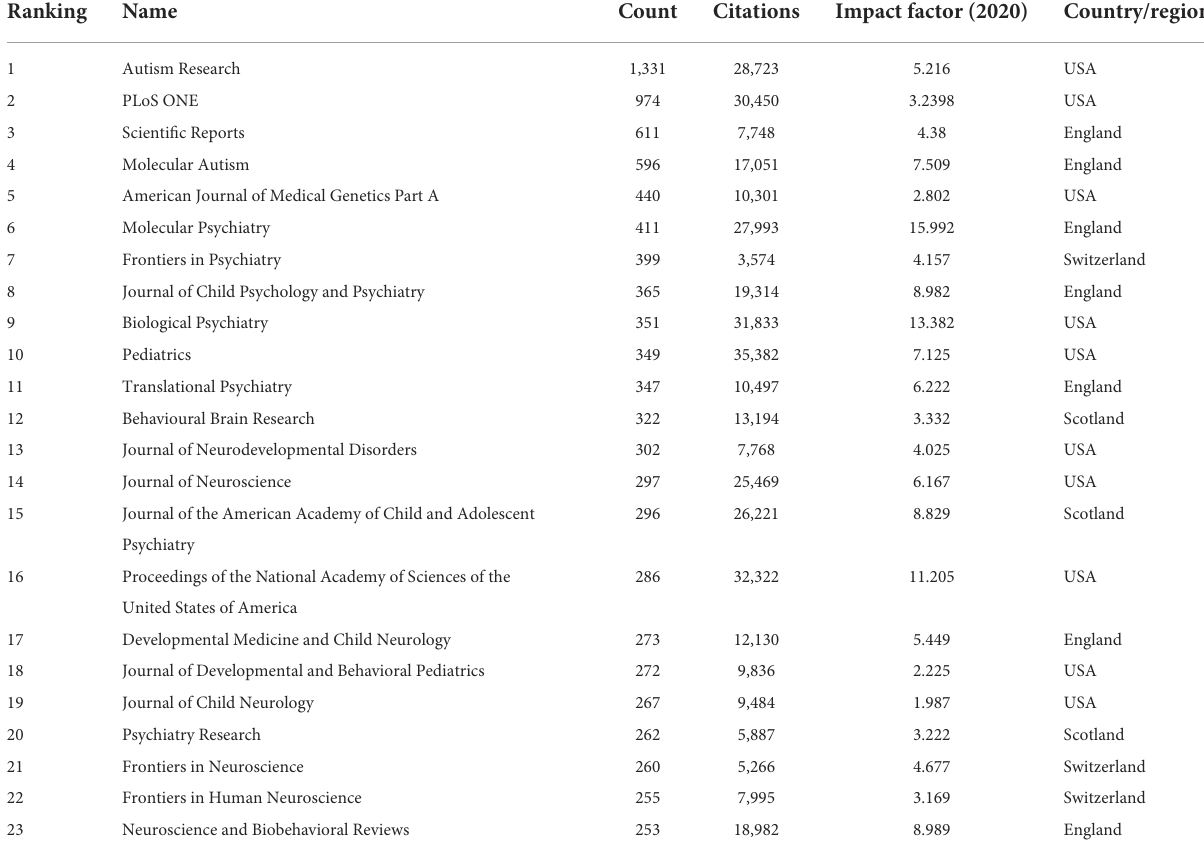
TABLE 2 The top 23 journals related to ASD